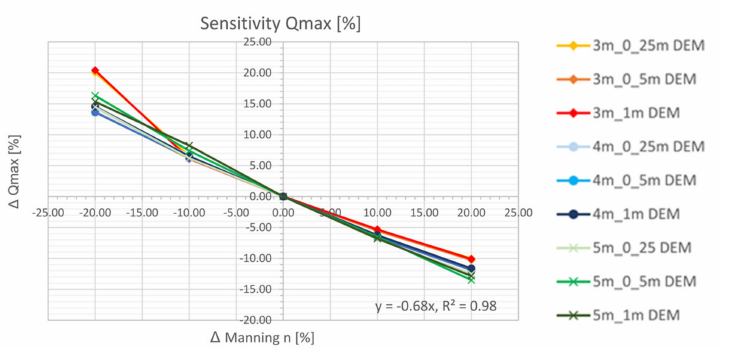
Figure 28. Comparison of the model sensitivity (S-Qmax) for Manning’s n values and the evaluated mesh and DEM resolutions with the averaged elasticity ratio e.